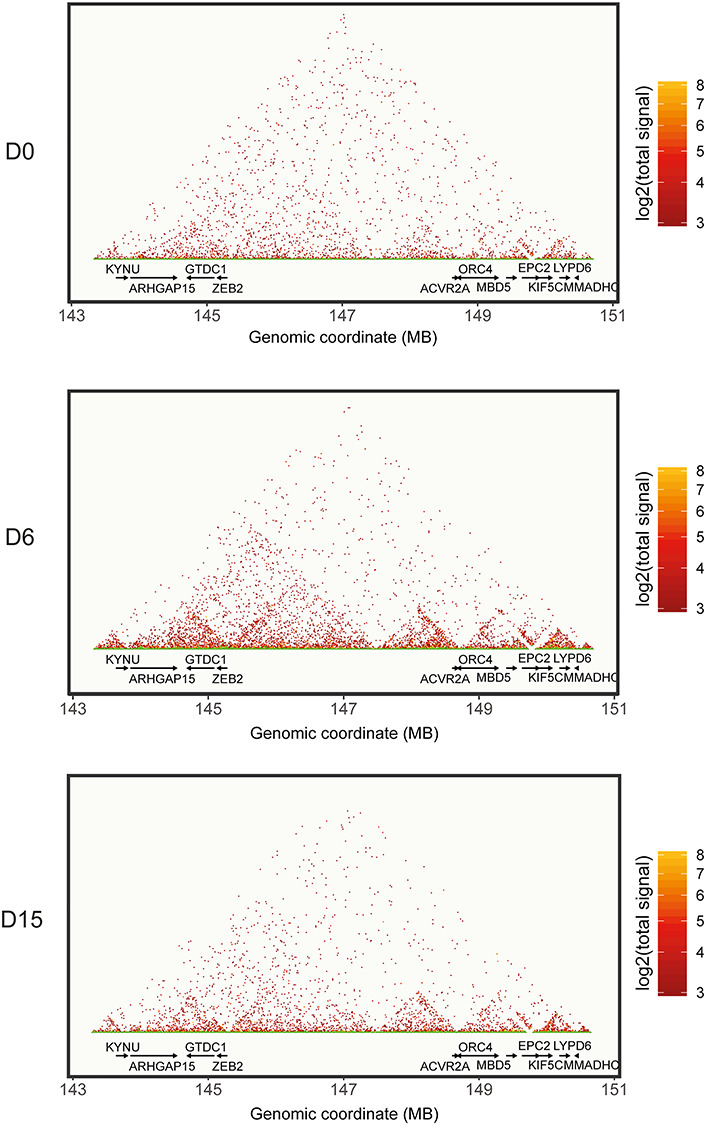

ZEB2 locus dynamics during neural differentiation. Reconstruction of in-cis proximity interactions on the human chr2:143:151 region, including the ZEB2 locus and the other annotated genes, in pluripotent (top panel, D0) and neural differentiating (D6, D15) iPSCs. To improve graphical clarity, the signals were binned to get a resolution of 20 kb.